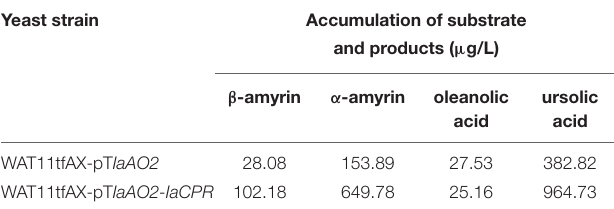
TABLE 1 | Accumulation of substrates and products in yeast strains expressing IaAO2